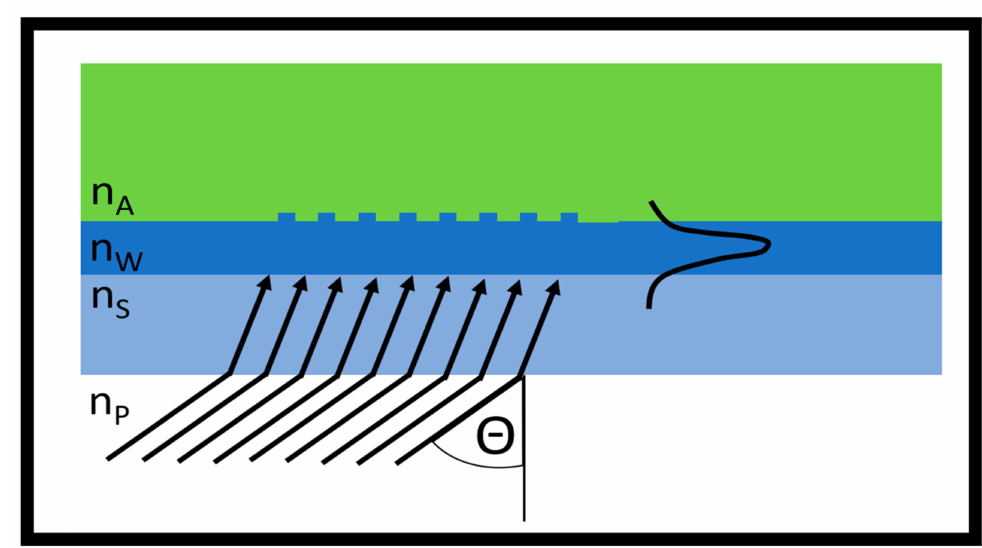
Figure 4. Schematic operation of a vertical grating coupler (VGC)-based sensor. Adapted from ref. [57].